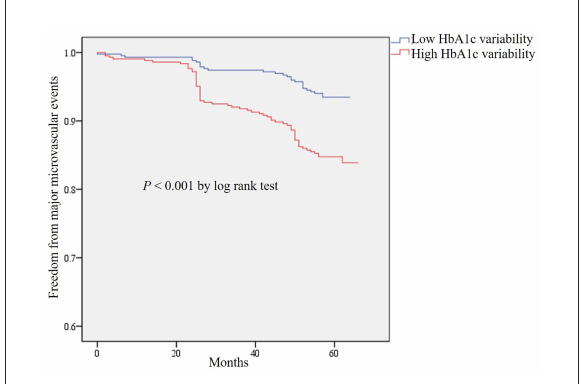
FIGURE2 Kaplan–Meier curves of freedom from major microvascular events for HbA1c variability in total